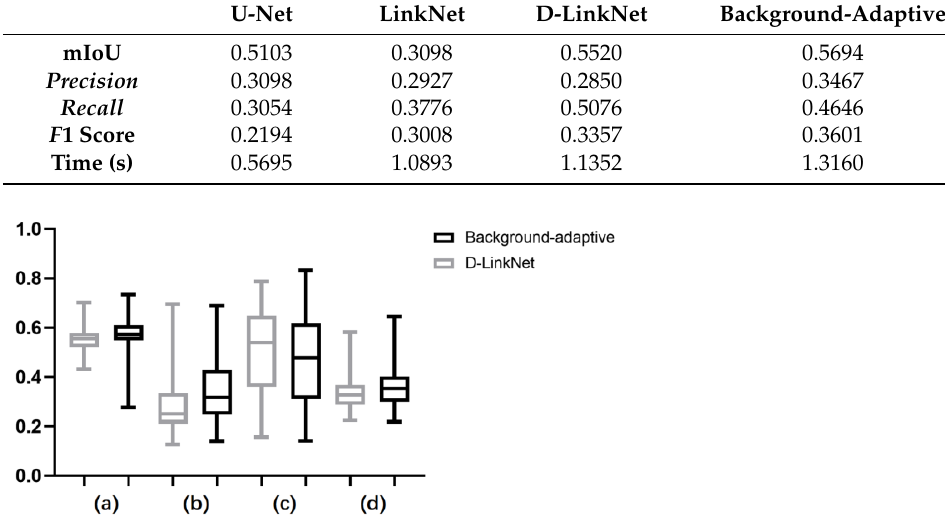
Figure 8. The box diagram for statistical analysis. ( a ) mIoU; ( b ) Precision ; ( c ) Recall ; ( d ) F 1 score.